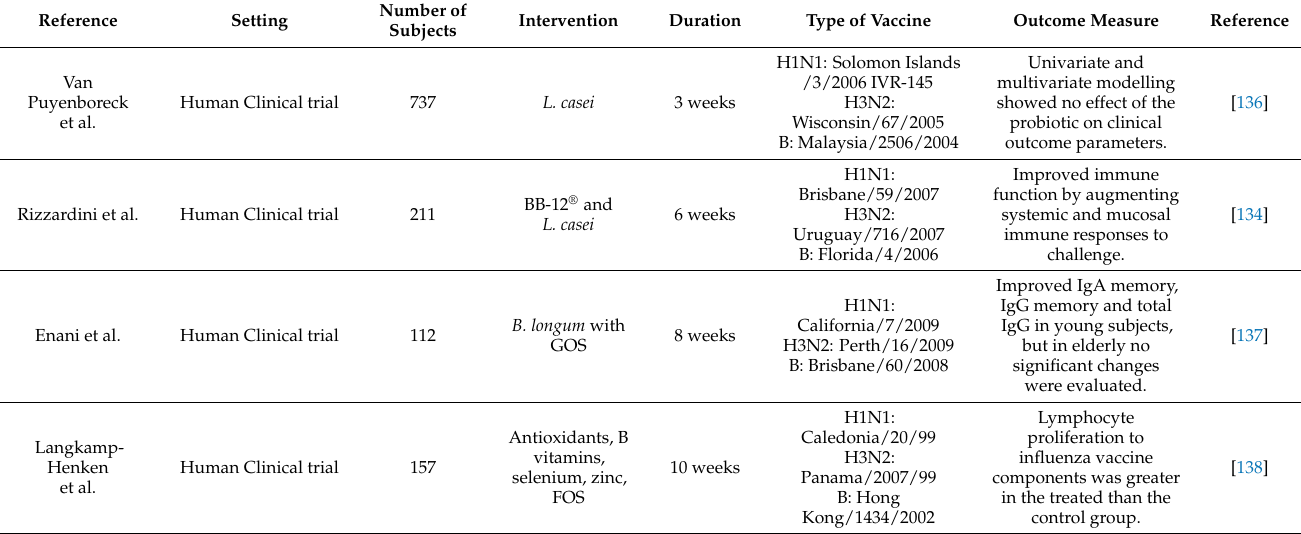
Table 2. Relevant studies on prebiotics/probiotics supplementation and response to